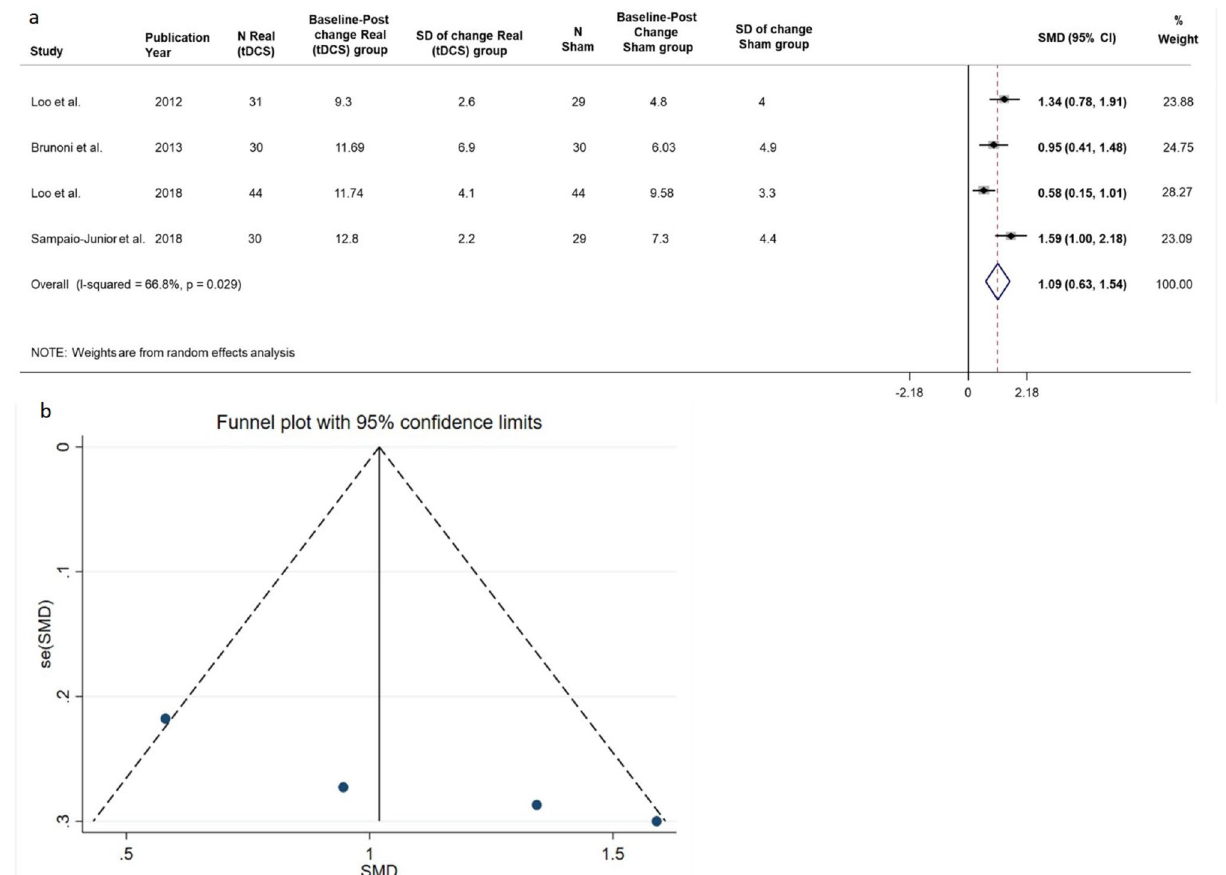
Figure 5. Depression. Real Vs Sham. ( a ) Forest plot of meta-analysis results considering all studies. The diamond represents the pooled standardized mean difference (SMD, dashed red vertical line) and its 95% confidence interval; vertical solid dark line is the line of equivalence. The estimates for each study and their 95% confidence intervals are represented by a box with whiskers, the dimension of grey box is proportional to the precision of the study. ( b ) On y-axis is represented the standard errors of the studies from lowest to higher, on x-axis the estimated SMDs; the solid vertical line represents the pooled SMD and diagonal dashed line represents its 95%